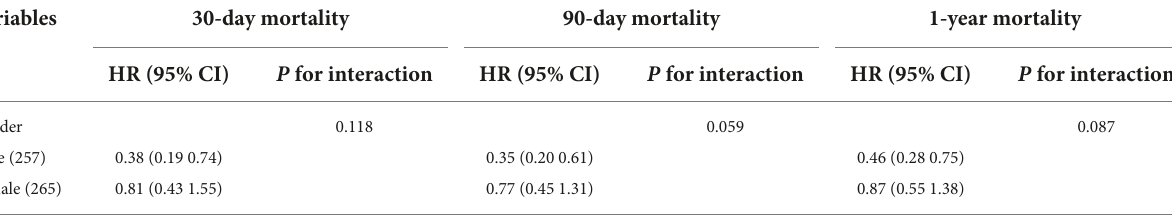
TABLE 5 Association between body mass index (BMI) and ischemic stroke outcomes stratified by age, sex, and diabetes.